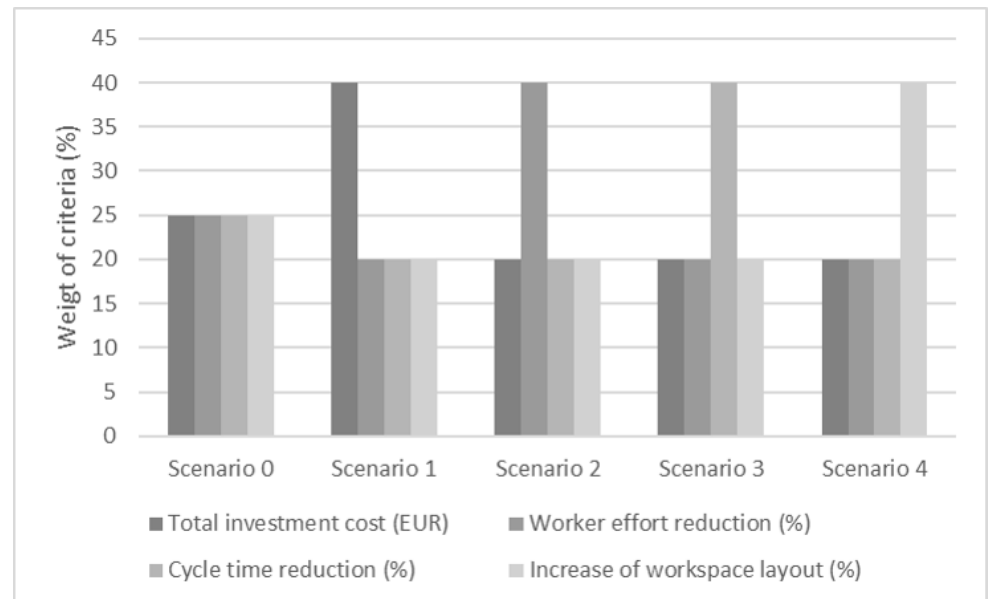
Figure 6. Different criteria weight for each scenario.